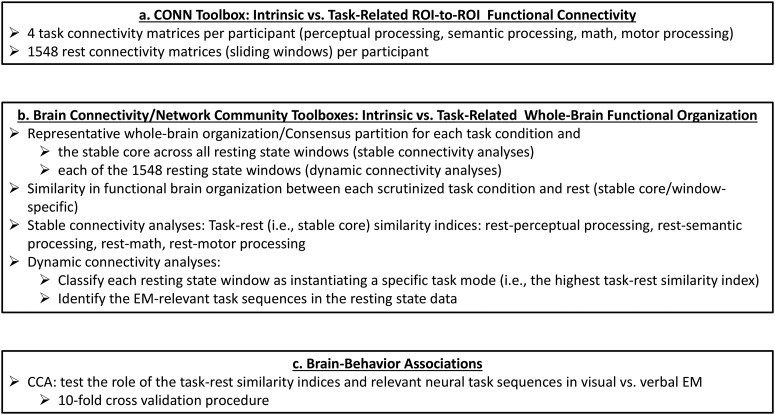
Schematic representation of our analysis pipeline.